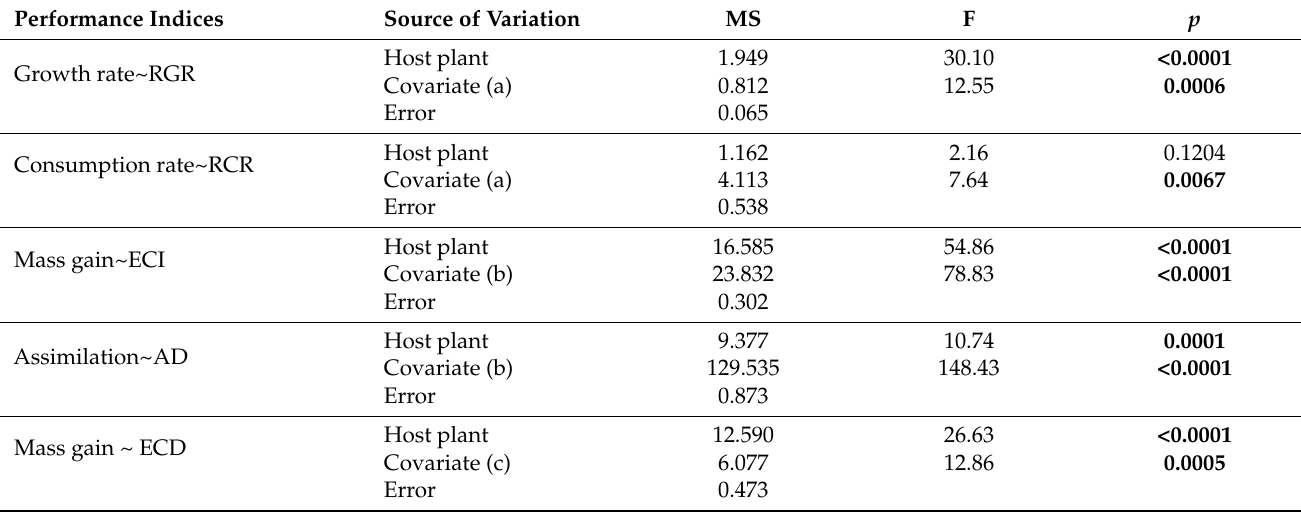
Table 5. MS, F and p values from ANCOVA for performance indices. Initial mass (a), consumption (b) and assimilation (c) were used as covariates. Each ANCOVA analysis represent equivalent to Waldbauer’s indices (Waldbauer, 1968). Host plant was fixed factor. Degrees of freedom: df = 2 for host plant effect, df = 1 for covariate and df = 103 for error term. Significant effects are marked in